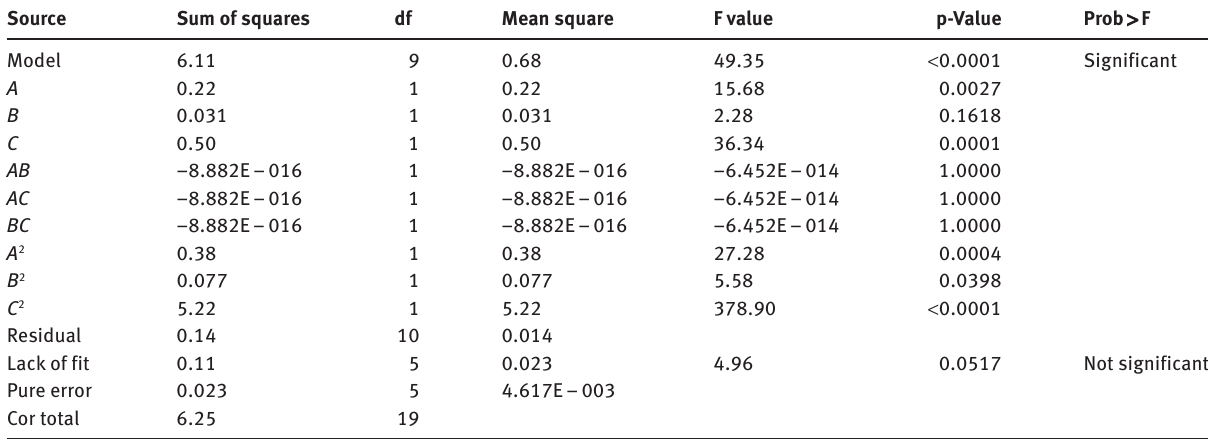
Table 4: ANOVA values of the response surface quadratic models for permeation flux.